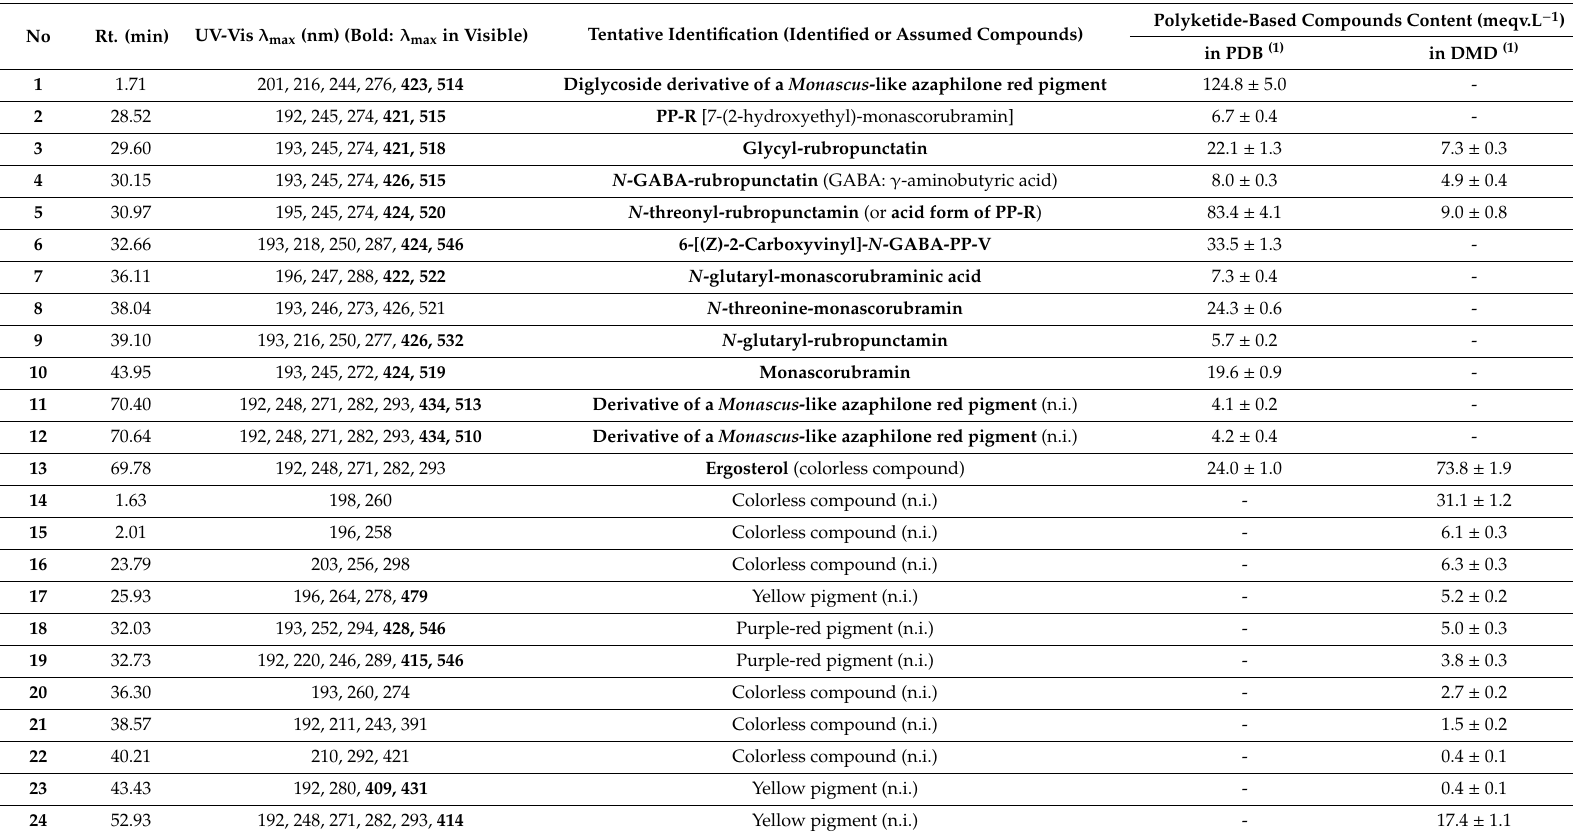
Table 2. Overall compounds identified from the fungal extracts of the marine-derived Talaromyces sp. 30570 fungal strain cultivated in 2 di ff erent submerged cultures: in Potato Dextrose Broth (PDB) and in Defined Minimal Dextrose broth (DMD), with reference to the chromatograms shown in Figure